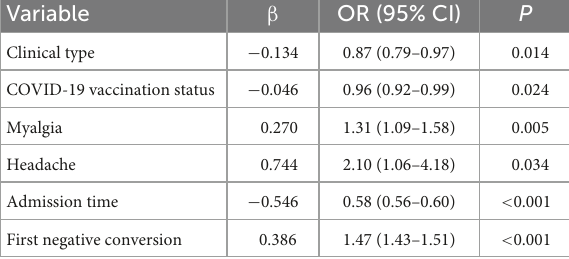
TABLE 3 Multivariate logistic regression analysis of recurrent positive based on data in the training cohort.